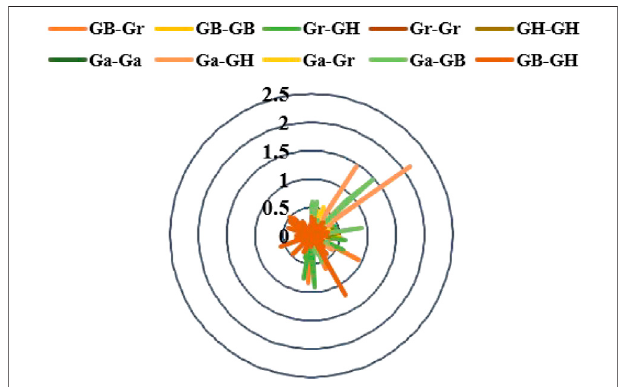
FIGURE 8 | Analysis of differentially expressed KCS gene family members in G. barbadense (* p < 0.05, ** p < 0.01).